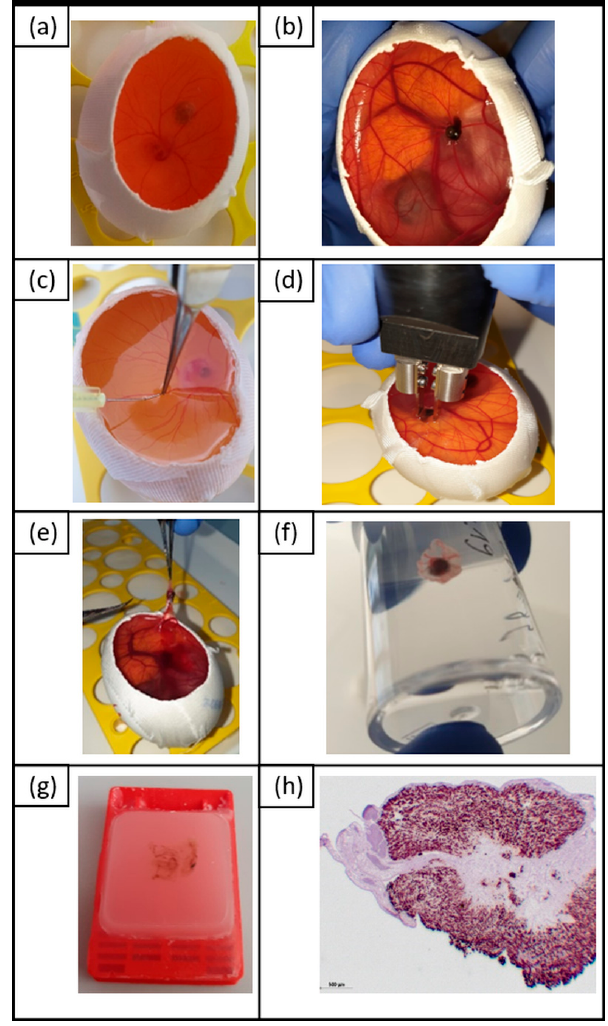
Figure 8. Overview of in vivo CAM assay to study the impact of ECT on human UM cells 92.1. ( a ) Chick embryo with Matrigel graft at E4; ( b ) chick embryo with Matrigel graft at E11; ( c ) intraarterial injection of bleomycin at E11; ( d ) EP of 3D tumor organoid at E11; ( e ) rejection of 3D tumor organoid at E16; ( f ) fixating cell ‒ Matrigel grafts with surrounding chick embryo tissue in 4% paraformaldehyde at E16; ( g ) FFPE sample of cell ‒ Matrigel graft with surrounding chick embryo; ( h ) immunohistochemical staining of human tumor cells in FFPE samples of CAM; tumor cells are stained with antihuman melanosome (in brown).